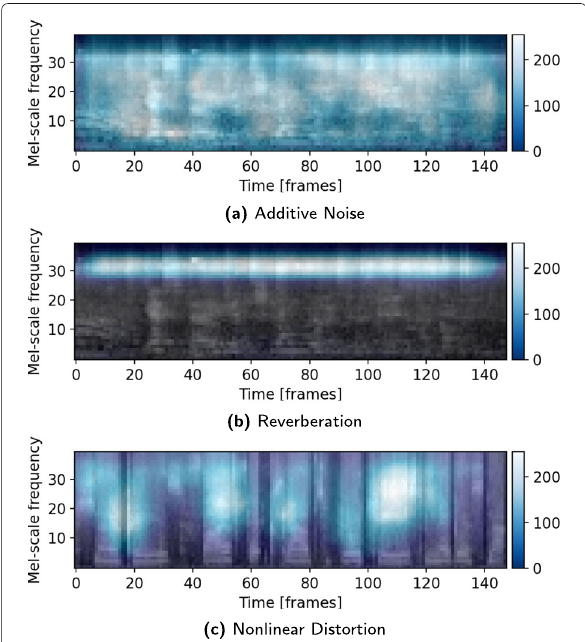
Fig. 4 Visualization of the saliency map, plotted in blue shading on top of the gray-scale signal spectrogram, by applying the score-CAM method to the log-mel spectrogram of a normal running speech signal degraded by three types of degradation. The intensity of the saliency map, shown on a scale of 0 to 255 by the colorbars, illustrates the importance of each region of the input space to the target class to be able to generalize for noise types not seen during the training phase.